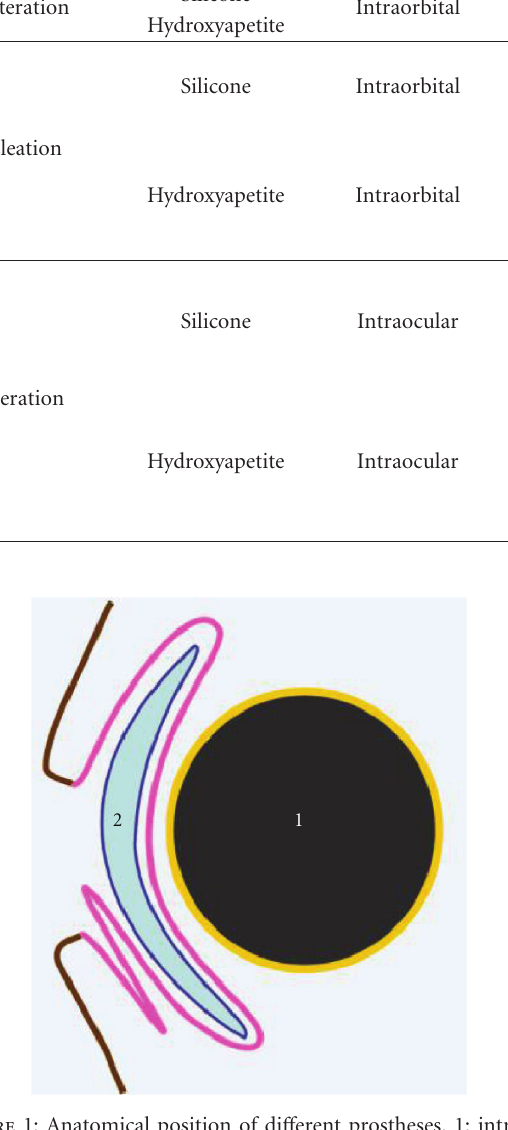
Figure 1: Anatomical position of di ff erent prostheses. 1: intraoc- ular prosthesis introduced within the empty tunica fibrosa after evisceration. 2: second extraocular prosthesis or “artificial eye,” lying between the conjunctiva (third eyelid in animals) and eyelids. Brown: eyelid skin, pink: conjunctiva, and yellow: tunica